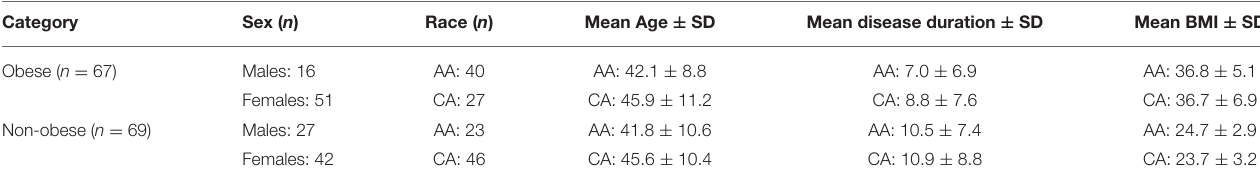
TABLE 1 | Demographics summary of